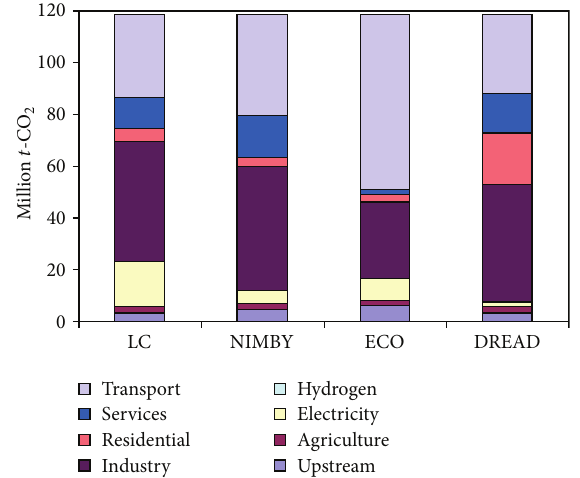
Figure 1: Sectoral CO 2 emissions in 2050. Scenarios are the low carbon (LC) baseline and the three socio-environmental forms (NIMBY, ECO, and